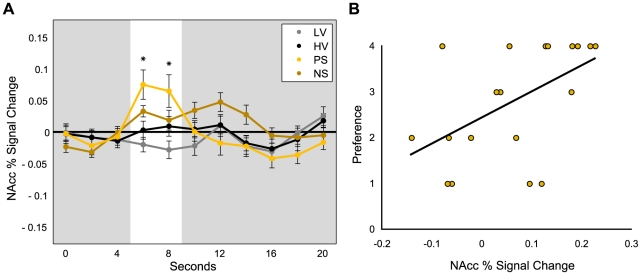
NAcc activation predicts Positive-Skew preference.
A. Timecourses extracted from NAcc for different gambles (*Positive-Skew vs. Low-Variance, High-Variance and Negative-Skew, p<0.05). Lines represent standard errors of the mean. The white bar highlights the anticipatory period (shifted by 6 s to account for the hemodynamic lag). B. NAcc percent signal change plotted with preference for Positive-Skew gambles (r = 0.53, p<0.01).